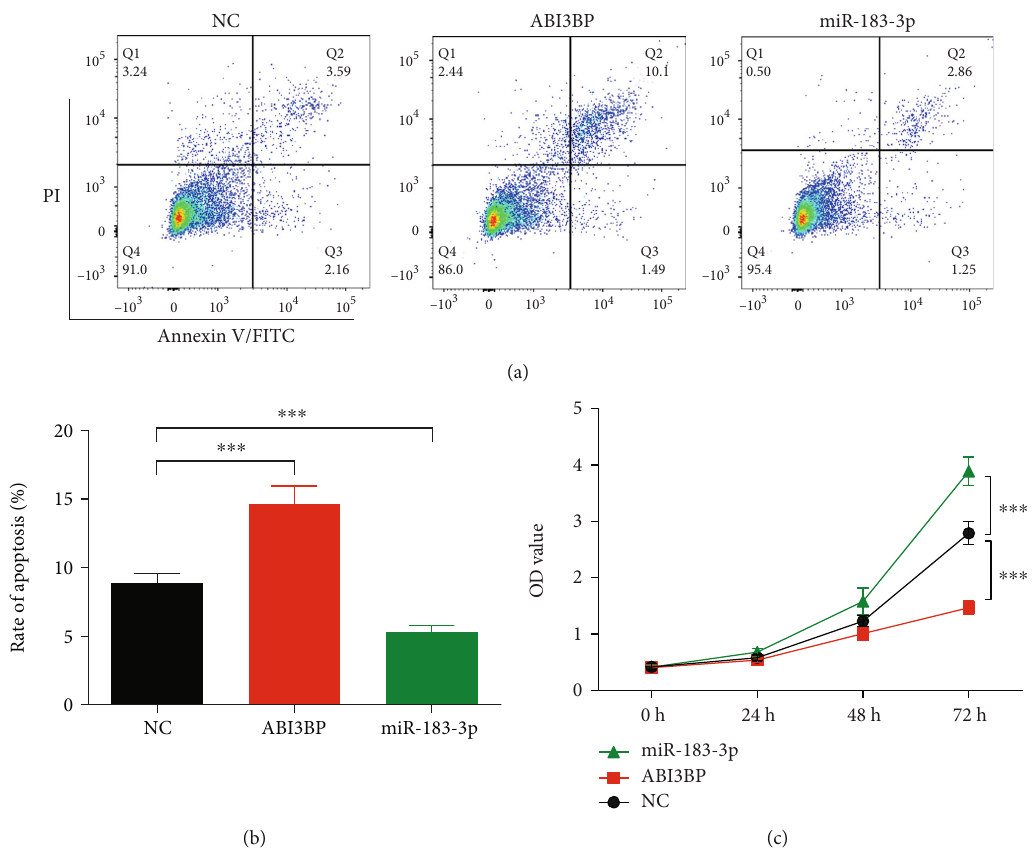
Figure 5: ABI3BP and miR-183 modulate the apoptosis and proliferation in EC cells. (a) After being transfected with ABI3BP or miR-183 for 24h, fl ow cytometry assay was performed to detect the rate of apoptosis in Eca-109 cells under ABI3BP or miR-183 overexpression conditions. Three independent experiments ( n = 3 ) were repeated for each group. (b) Quantitative analysis of Figure 5(a). (c) After being transfected with ABI3BP or miR-183 for 24 h, CCK8 assay was performed to assess the proliferation of Eca-109 under ABI3BP or miR- 183 overexpression conditions. n = 5 for each group. ∗∗∗ P < 0 : 001 , one-way ANOVA with post hoc and two-way ANOVA with post